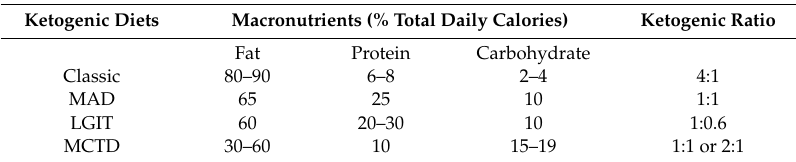
Table 1. The main types of Ketogenic